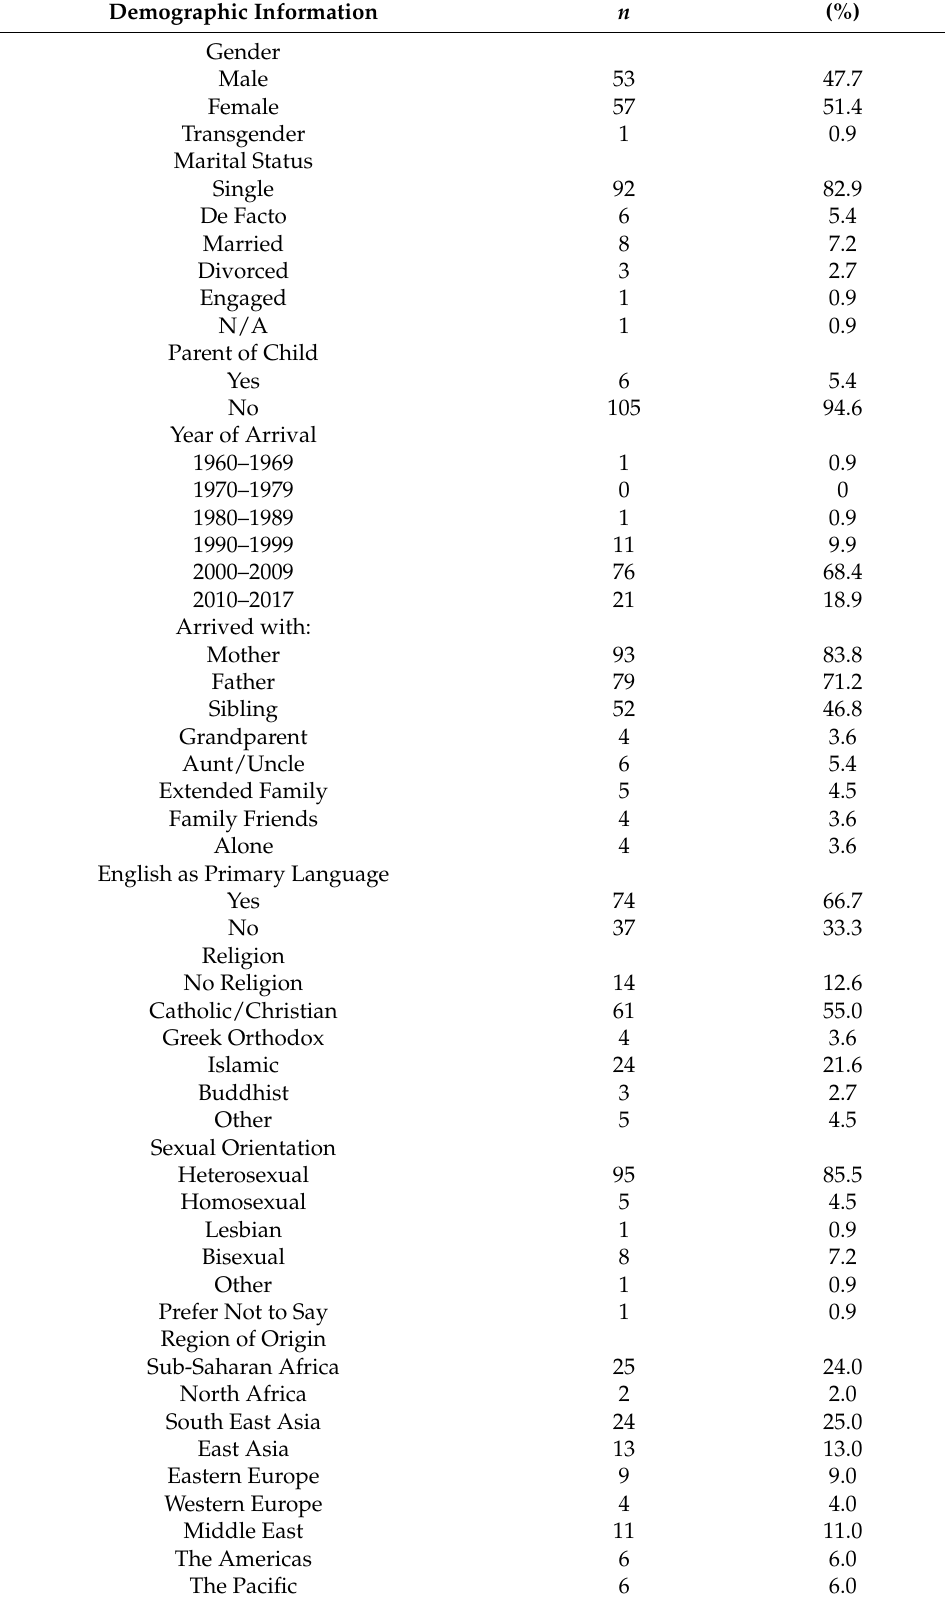
Table 1. Demographic information for the study